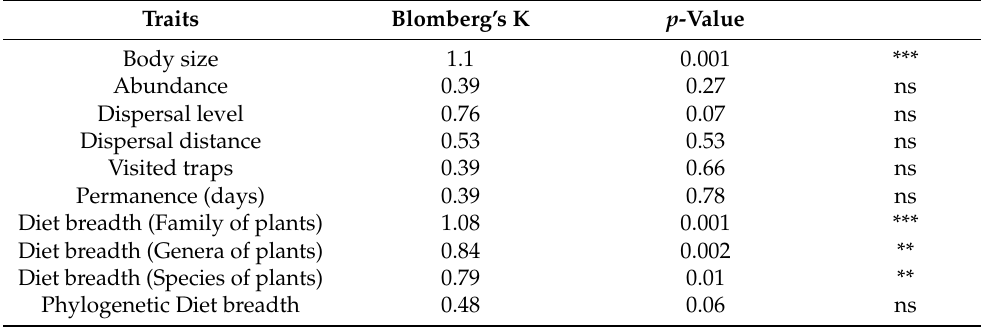
Table 2. Phylogenetic generalized least squares (PGLS) between body size and other species traits in fruit-feeding butterflies captured in Fazenda Á gua Limpa, Bras í lia, Brazil. Traits F Beta p -Value Abundance 7.2